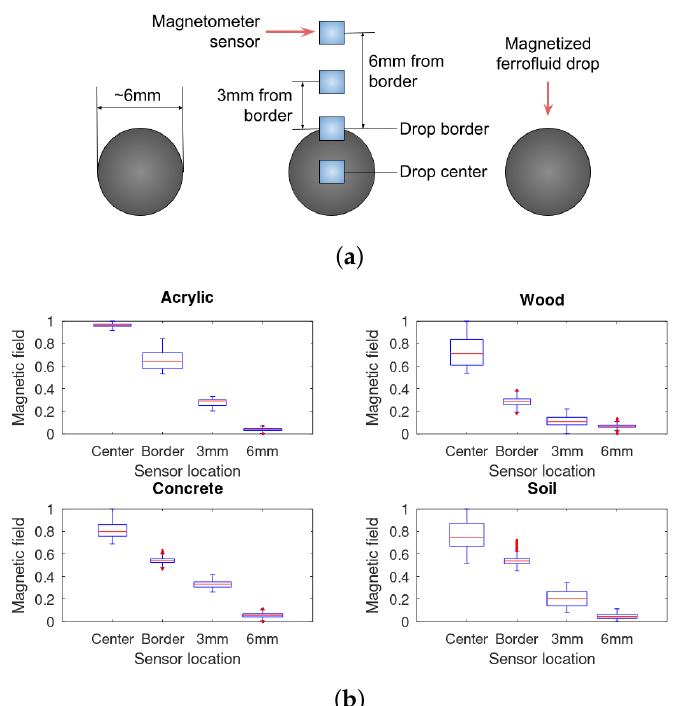
Figure 3. Locality and gradient validation on several surfaces at outdoor conditions. ( a ) Experimental set up: magnetic field were measured on center of the drop, approximate border, 3 mm from border and 6 mm from border. The sensor was placed approximately 10 mm above ground. Several measurements were carried out for each position. The reported environment temperature was 20 °C and 90% of humidity. ( b ) Normalized magnetic field intensity results on z axis of magnetometer for different